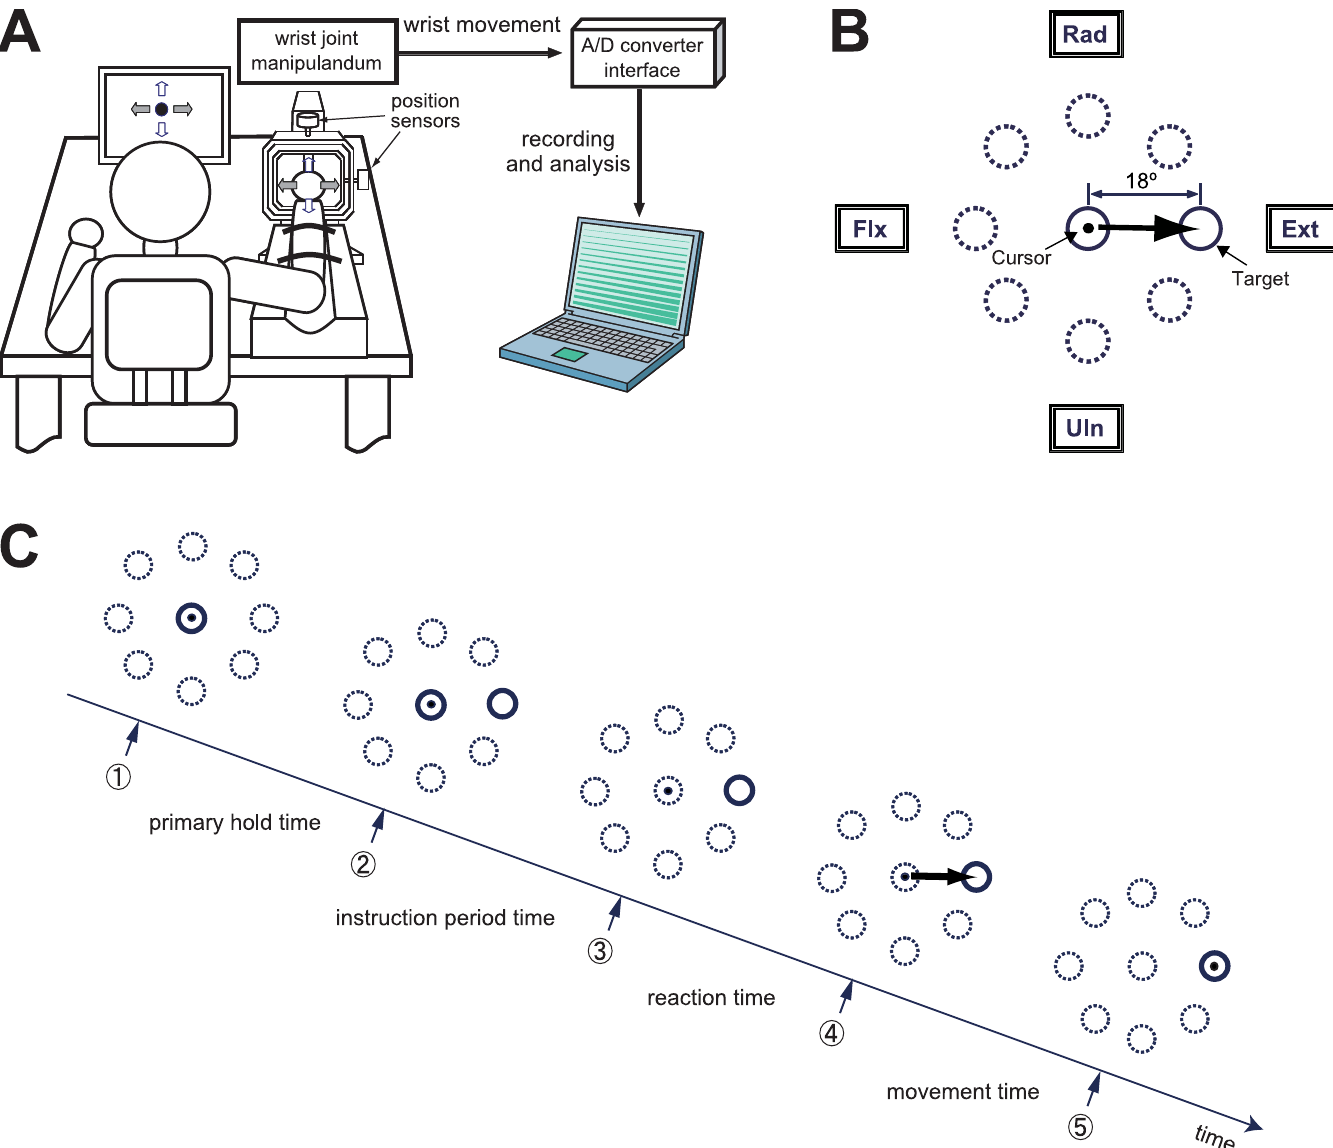
Fig 1. Experimental design and movement task. (A) Experimental setup. Each subject sat approximately 60 cm in front of a computer screen that displayeda cursor and a target, and graspeda Strick-Hoffman type manipulandumwith his/her right hand [30]. The handleof the manipulandum rotated freely aroundthe horizontal and vertical axes with low-friction. To perform the wrist movement task, the subject maintained his/her forearm in the neutral position,midway betweenfull pronationand full supination. Two position sensors that were coupledto the device measuredthe angle of the wrist in the planes of flexion-extension and radial-ulnar deviation. (B) Presentationof the targets and requiredmovement of a cursor for the step-tracking task used in this study. The target was displayedas an open circle with an internal diameterthat corresponded to a wrist movement of 4.5˚. The cursor was a black point (approximately 2 mm in diameter) that moved in proportionto the subject’s wrist movements. The positionof the cursor in the center target corresponded to the center of the screen, and the cursor moved left for flexion movements, right for extensionmovements, up for radial deviations, and down for ulnar deviations of the wrist. The subjects were requiredto move the cursor from the center target to one of eight targets that were randomlypresented, as rapidly and accuratelyas possible. (C) Procedureof the step-tracking task. First, the subject put the cursor in the central target. After 500 msec ( primary hold time ), a new target was randomlydisplayedin one of eight directions.After 500–1000ms ( instructionperiodtime ), the central target disappeared[start signal, (3) in figure], at which time the subject had to start moving the cursor. The subject was supposedto put the cursor in the new target as preciselyand fast as